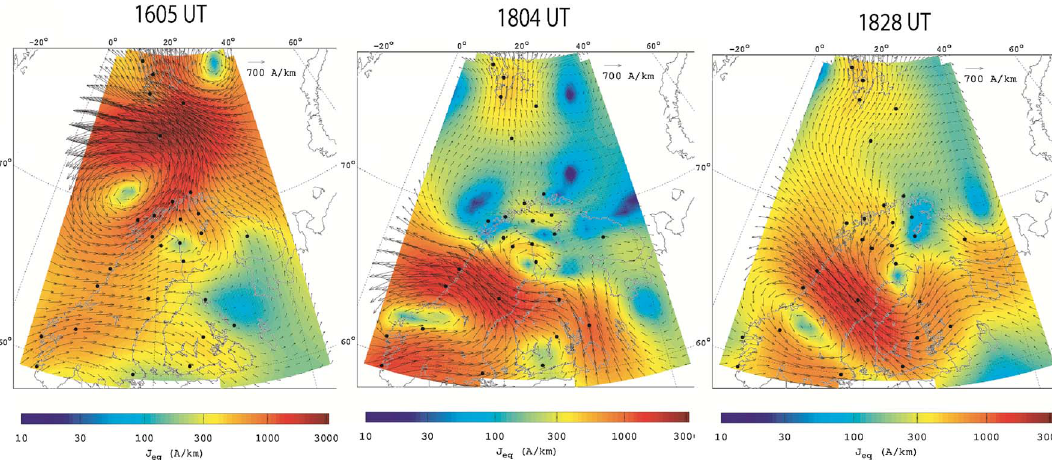
Fig. 6. The equivalent ionospheric current systems calculated with the method of 2D equivalent currents from the IMAGE magnetometer array during three impulses imposed on the substorm evolution at 16:05 UT, 18:04 UT, and 18:28 UT on 17 March 2013. Color coding indicates the density of height-integrated equivalent ionospheric